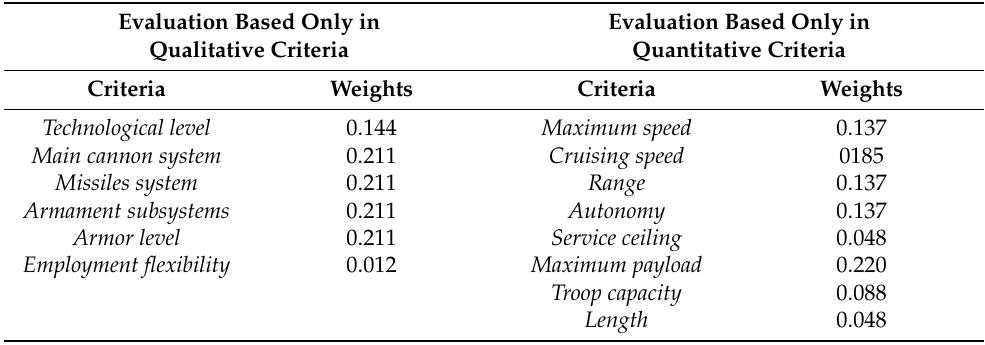
Table 18. Criteria weights in scenarios considering only quantitative or qualitative nature. Evaluation Based Only